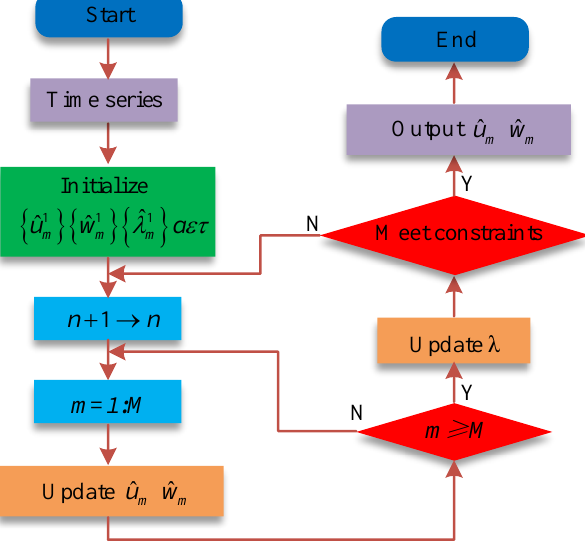
Figure 1. The calculation flow of the variational mode decomposition.